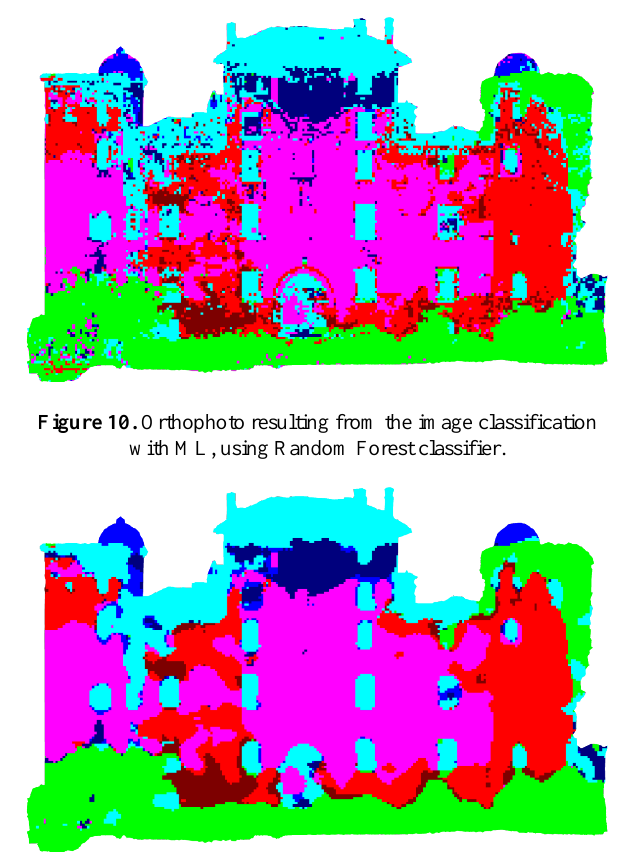
Figure 11. Classified orthophoto after postprocessing.